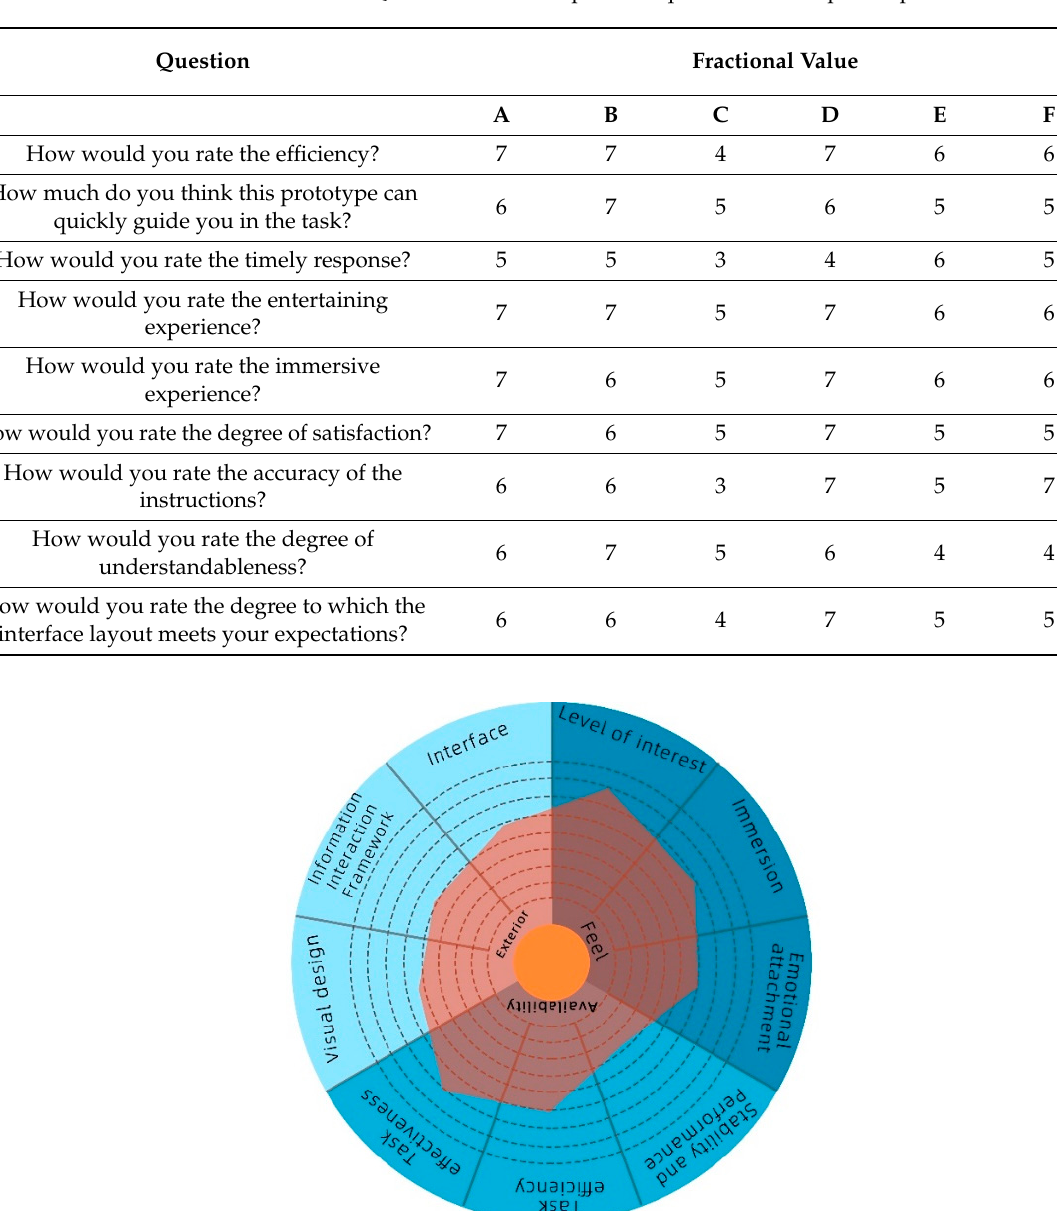
Table 3. Quantitative user experience questionnaire in post-experiment interviews.